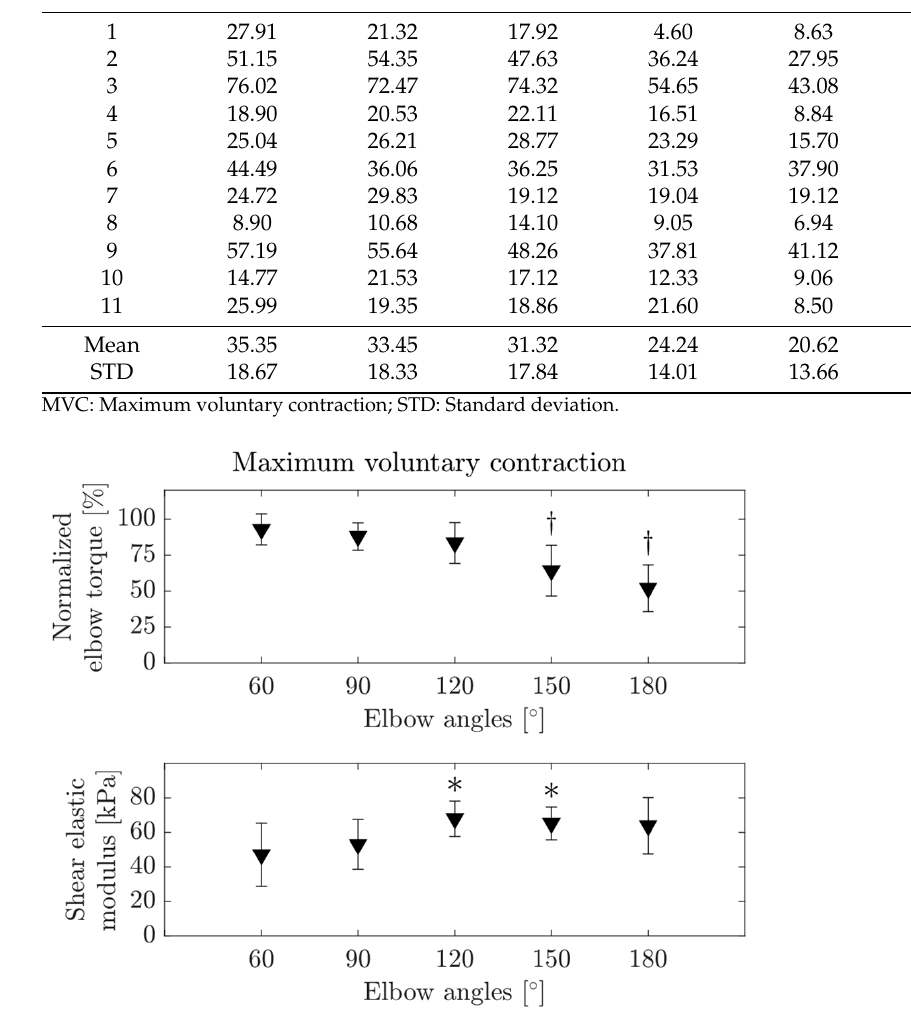
Figure 2. Average normalized elbow flexion torque and total shear elastic modulus of the biceps brachii muscle during maximum voluntary contractions at the five elbow angles studied (60 ◦ , 90 ◦ , 120 ◦ , 150 ◦ and 180 ◦ ). Error bars visualize the standard deviation. The cross and star signs indicate that the measured value is significantly different from the normalized elbow torque at 60 ◦ , 90 ◦ , 120 ◦ and the shear elastic modulus measured at 60 ◦ elbow angle ( p < 0.05), respectively. Table 3. Individual maximum elbow torque during maximum voluntary contraction (MVC) in fl exion and extension directions.